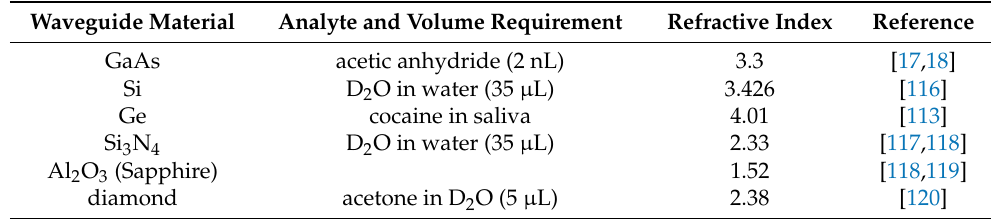
Table 1. Selected materials for analyte detection on a thin-film waveguide system in the MIR spectroscopic